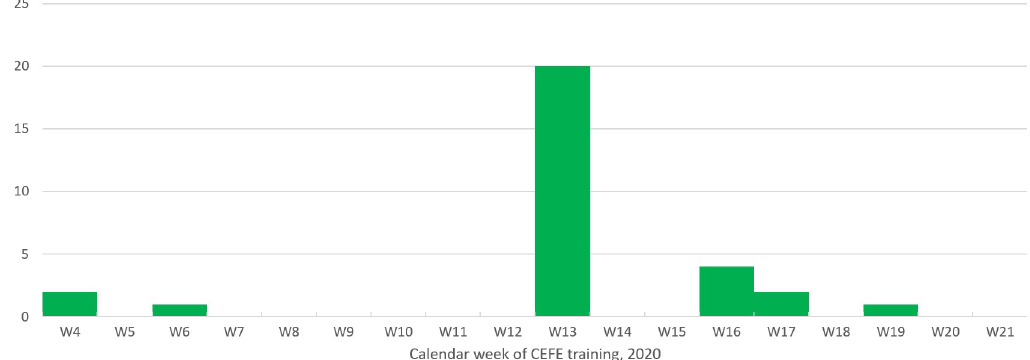
Fig 4. Number of confirmed cases of cutaneous leishmaniasis for each calendar week between February and June 2020, CEFE training site, French Guiana, 2020.